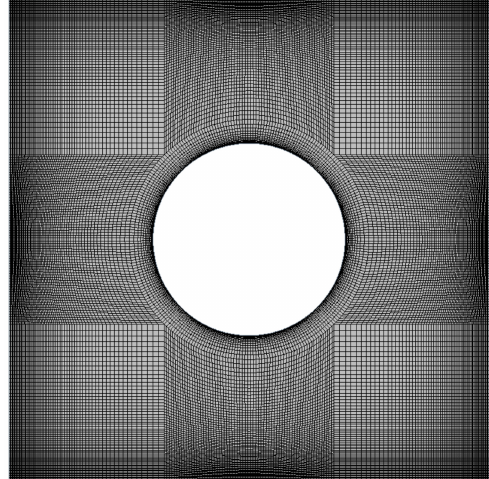
Figure 2. A typical grid distribution for r = 0.